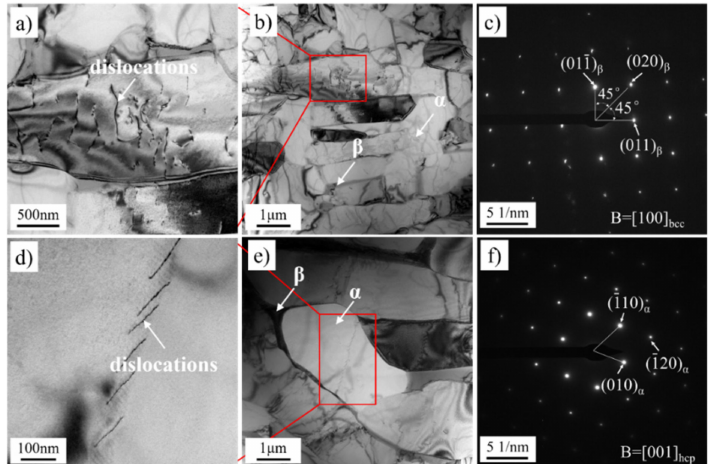
Figure 4. Transmission electron microscopy (TEM) characterization of as-built and HIPed samples, ( a ) dislocation of as-built sample, ( b ) TEM image of as-built sample, ( c ) electron di ff raction pattern of β phase, ( d ) dislocations of HIPed sample, ( e ) TEM image of HIPed sample, ( f ) electron di ff raction pattern of α